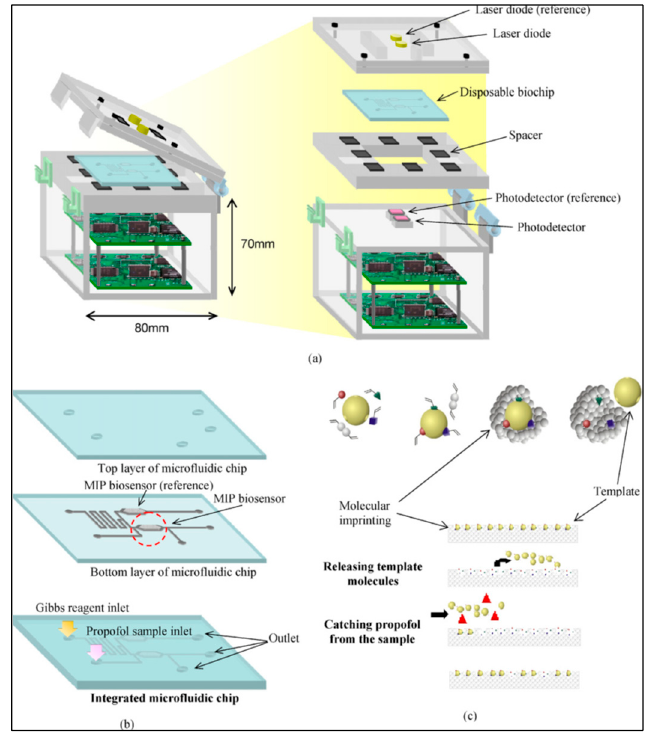
Figure 8. The microfluidic system with MIPs for propofol detection. Republished with permission from Hong et al. [57].